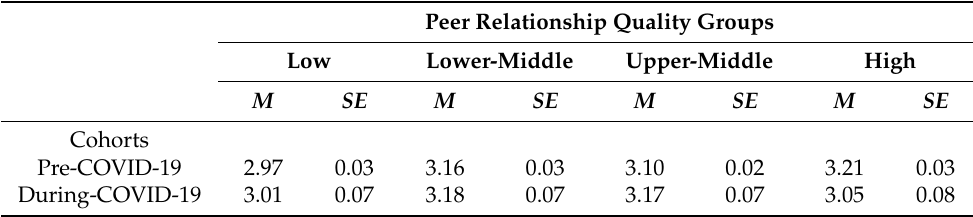
Table 5. Estimated average values of life satisfaction by cohorts and peer relationship quality groups.